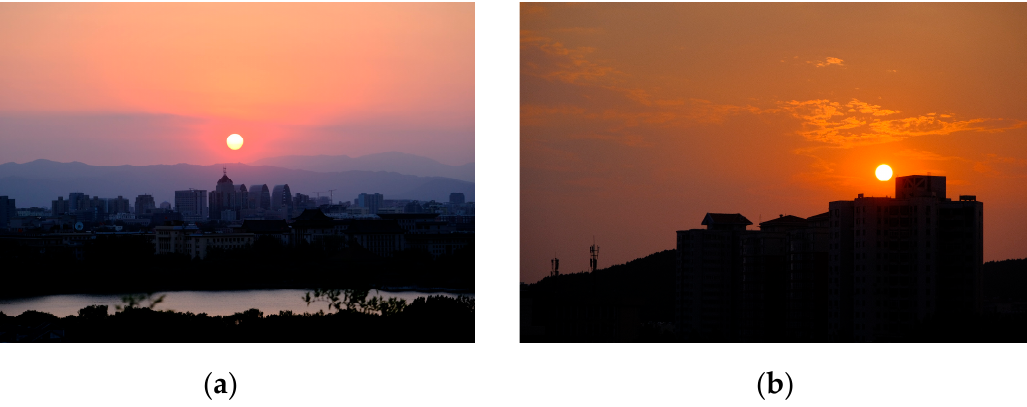
𝐴𝑃 𝐴𝑃 𝐴𝑃 𝐴𝑃 𝐴𝑅 𝐴𝑅 𝐴𝑅 (cid:2868).(cid:2873) , (cid:3020) , (cid:3014) , (cid:3013) , (cid:2868).(cid:2873) , (cid:3020) , (cid:3014) , and cator are shown in bold.